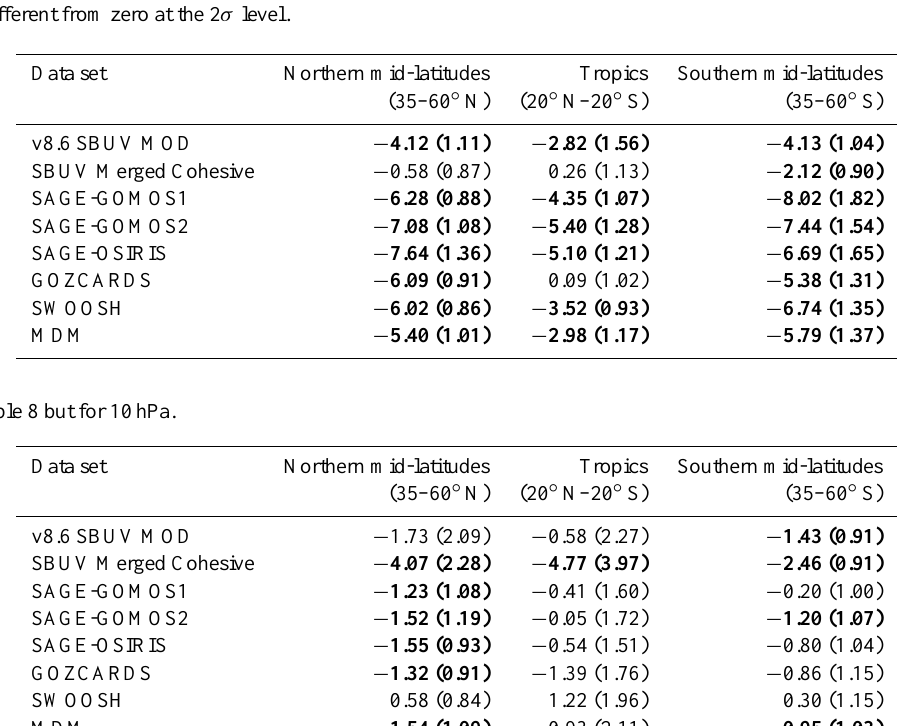
Table 8. Trends in %decade − 1 for the 1984–1997 period at 2hPa. Values in brackets show the 2 σ uncertainty estimates, while those in bold are significantly different from zero at the 2 σ level.